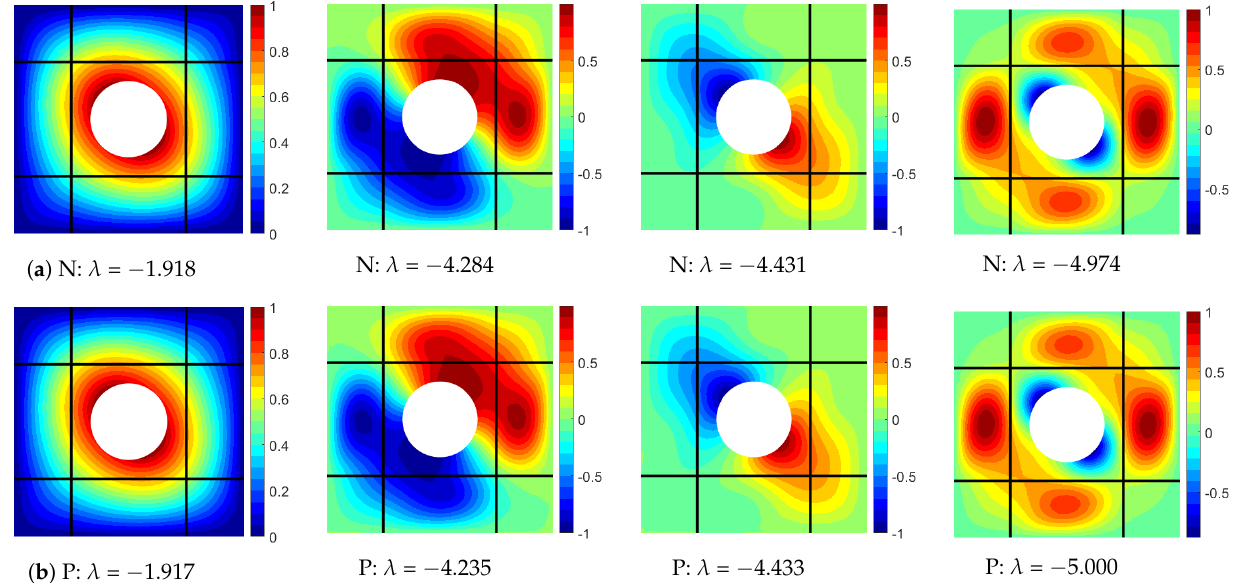
Figure 14. Comparison of buckling eigenvalue ( λ ) and buckling mode shapes of the stiffened VAT laminates with a central hole under in-plane shear displacements. ( a ) N: NASTRAN results; ( b ) P: Present results.